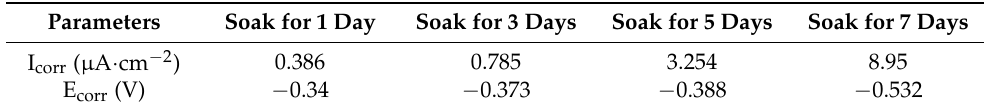
Table 4. Corrosion characteristics parameter table of 3D-printed + corroded samples immersed in simulated seawater for different times.